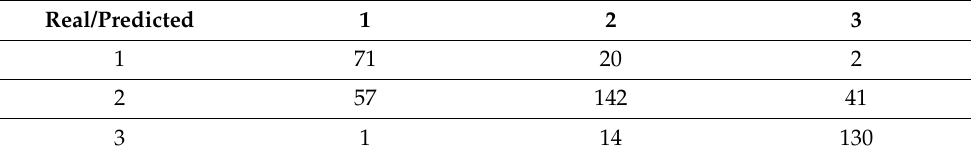
Table 6. Random Forest confusion